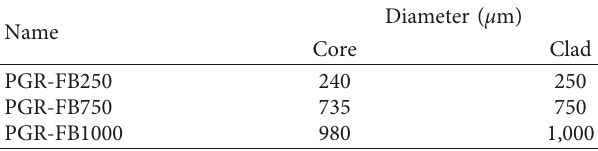
Table 2: Detailed dimensions of three types of POF specimens.